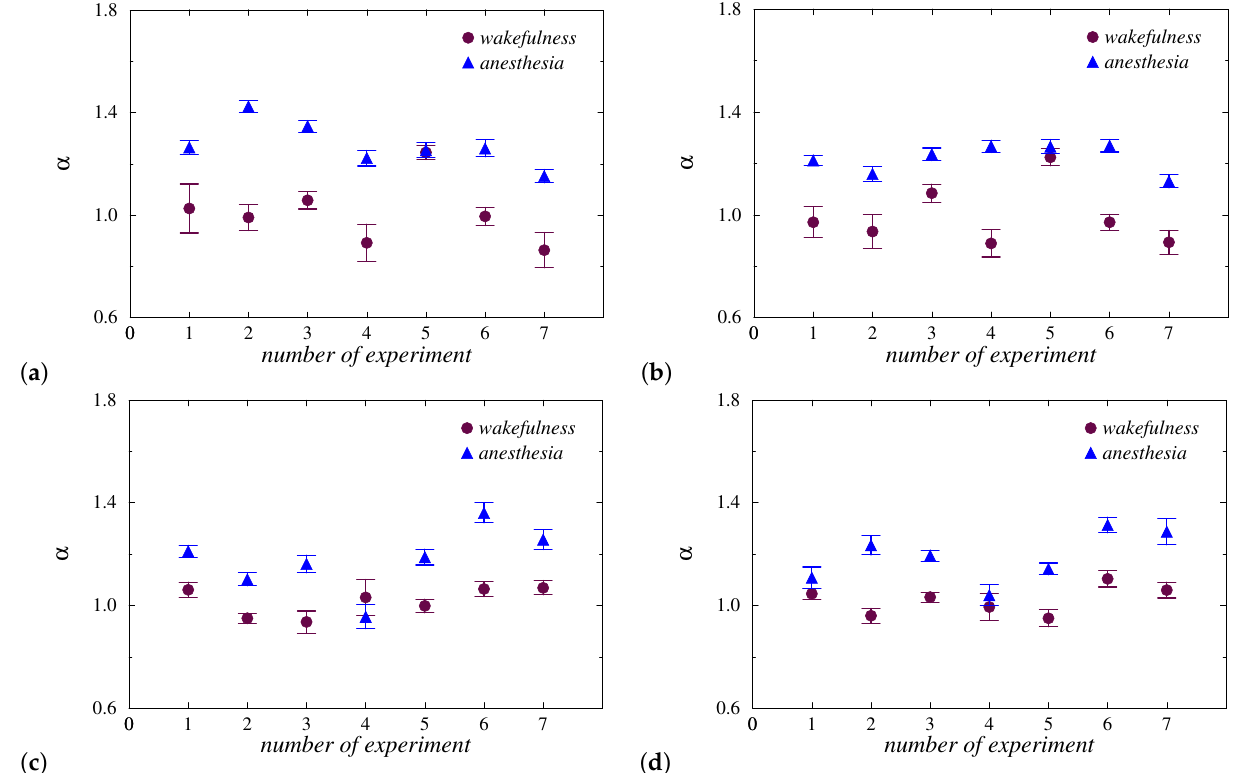
Figure 4. Local α -values for groups of animals for injection ( a , b ) and inhalation ( c , d ) anesthesia. Results are shown for the 1st ( a , c ) and 2nd ( b , d ) EEG